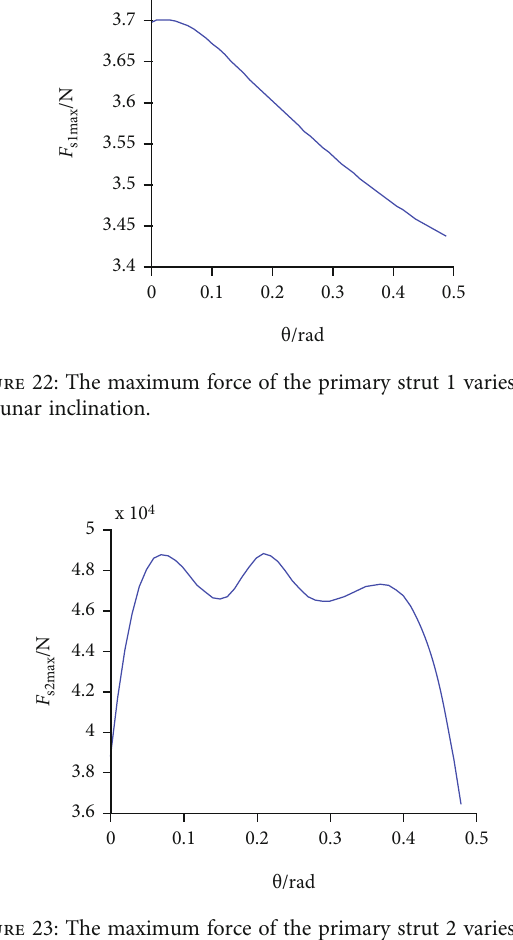
Table 13: Impact on the minimum body displacement under typical lunar inclination conditions.